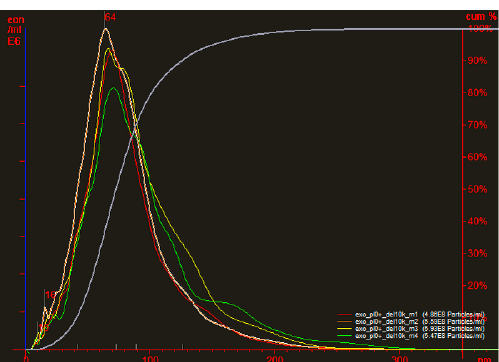
Figure A1. Nanoparticle tracking analysis of particle size and concentration. The initial sample was diluted 10,000 times.